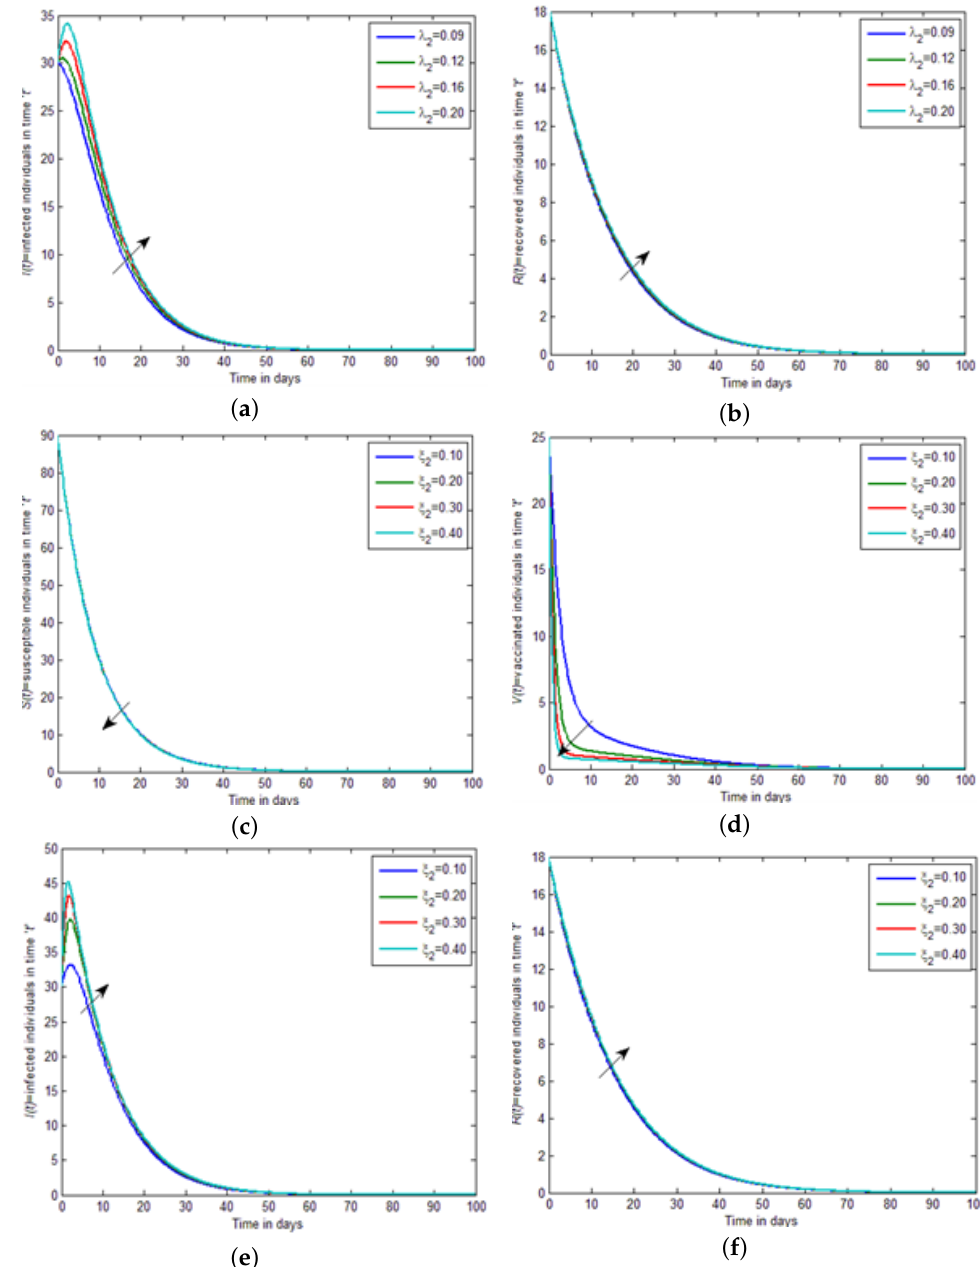
Figure 3. Numerical simulations of the model variables ( a ) S ( t ) , ( b ) V ( t ) , ( c ) I ( t ) , and ( d ) R ( t ) for different values of ‘ λ 2 ’ and ( e ) S ( t ) , ( f ) V ( t ) , with different values of ‘ ξ 2